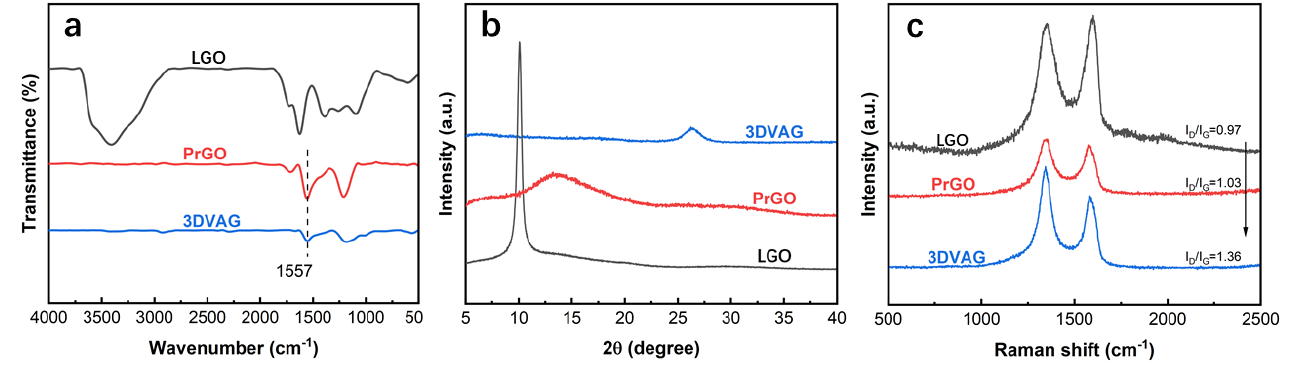
Figure 7. Chemical composition and structural characterization of different materials: ( a ) FTIR spectrum; ( b ) XRD; ( c ) Raman spectrum.